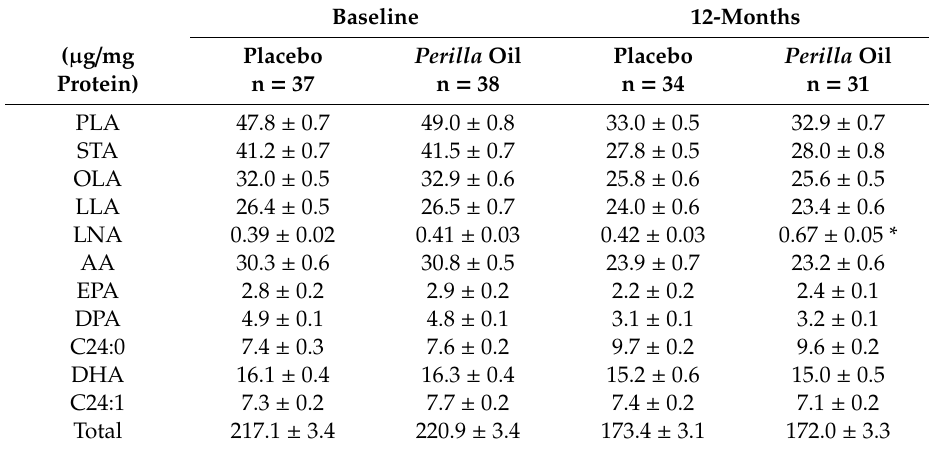
Table 4. Fatty acid profile of the erythrocyte plasma membranes at baseline and 12 months of perilla oil intervention. Baseline 12-Months ( µ g / mg